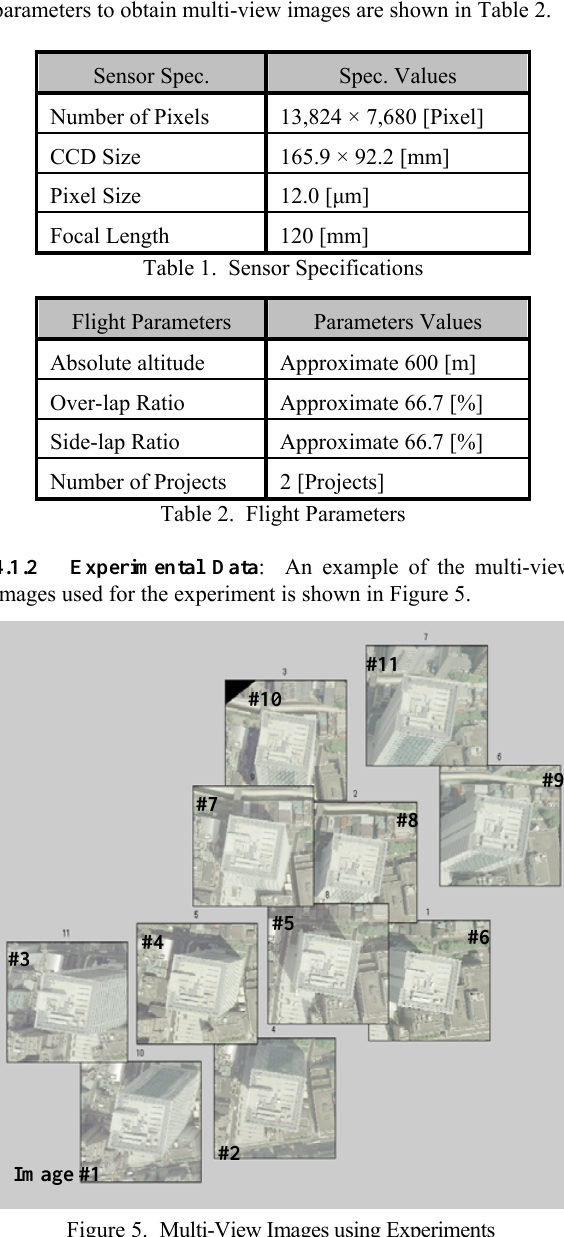
Figure 5. Multi-View Images using Experiments